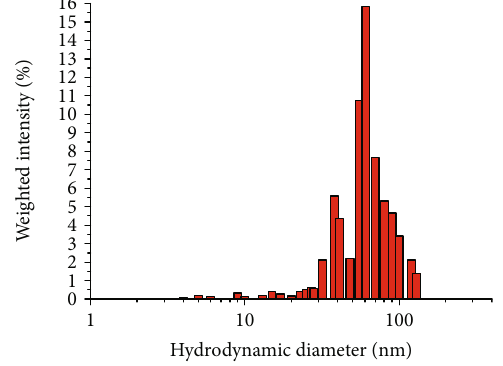
Figure 2: Hydrodynamic diameter distributions of scattering objects in Polymer/AuNP